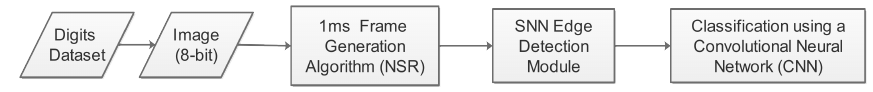
Figure 7. The process flow of the pipeline, which combines a 1 ms frame generator, SNN edge detector and a Convolutional Neural Network (CNN), for Digits classification.